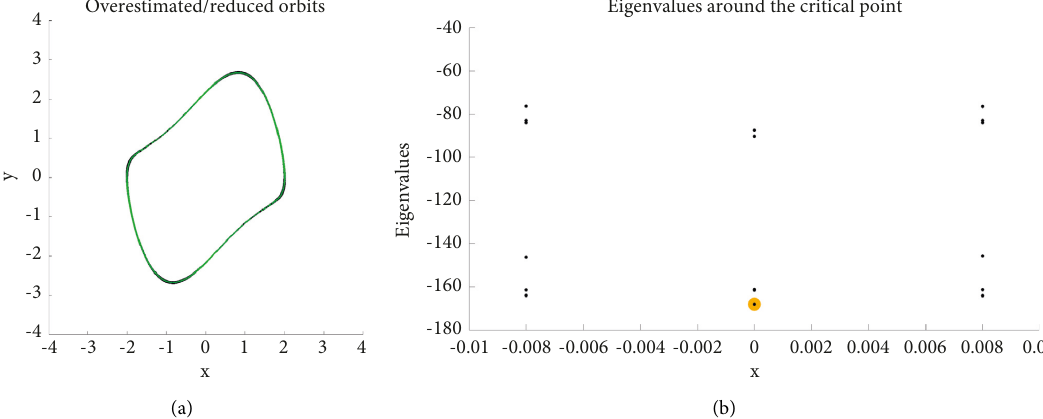
Figure 10: System (20). (a) The overestimation of the chain recurrent set 􏽥 X 0 � C chain recurrent set is plotted in green. We include points if there is one positive and one zero eigenvalues. (b) Eigenvalues of the points in 􏽥 X 0 close to the critical point at the origin. Both are negative, so v must have a maximum, that is, the critical point is unstable with a 2- dimensional unstable